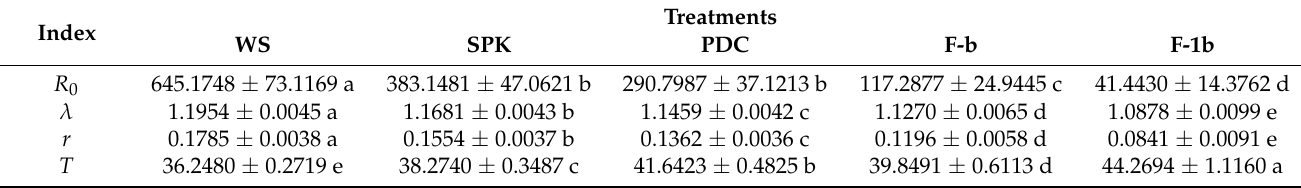
Table 4. Population parameters of the FAW fed on different wheat tissues in the